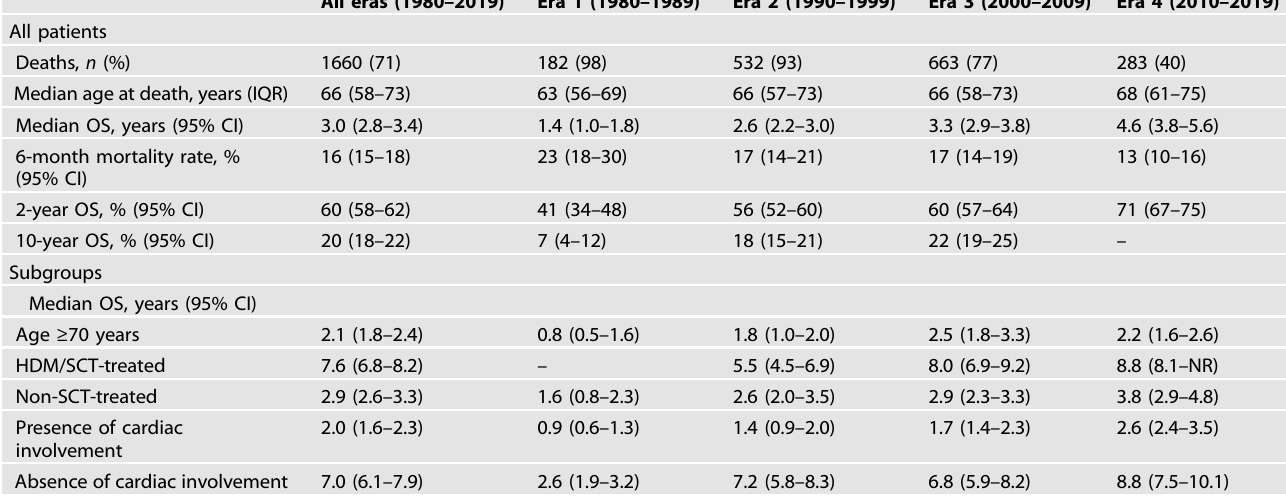
Table 2. Survival intervals and rates by era of diagnosis.